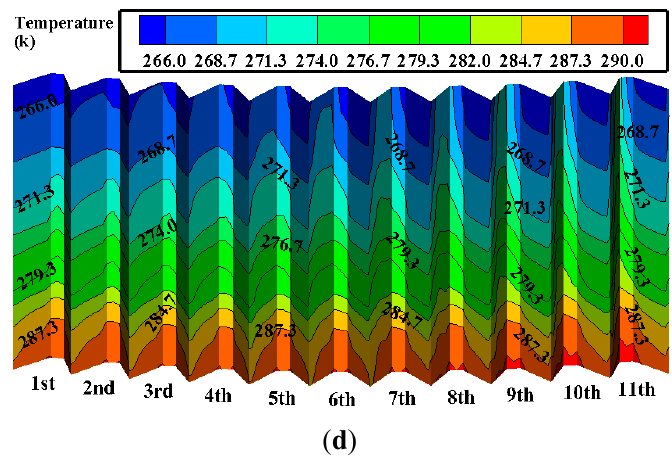
Figure 8. Variable fields of the frontal deltas. ( a ) Pressure and flow fields at 4 m/s, ( b ) pressure and flow fields at 12 m/s, ( c ) outlet air temperature at 4 m/s, ( d ) outlet air temperature at 12 m/s.